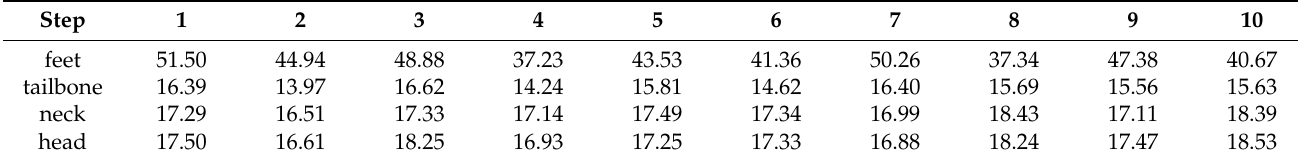
Table 3. Top acceleration: sport shoes [m/s 2 ]. Table 4. Ratios of the top acceleration damping between bare feet and sport shoes.